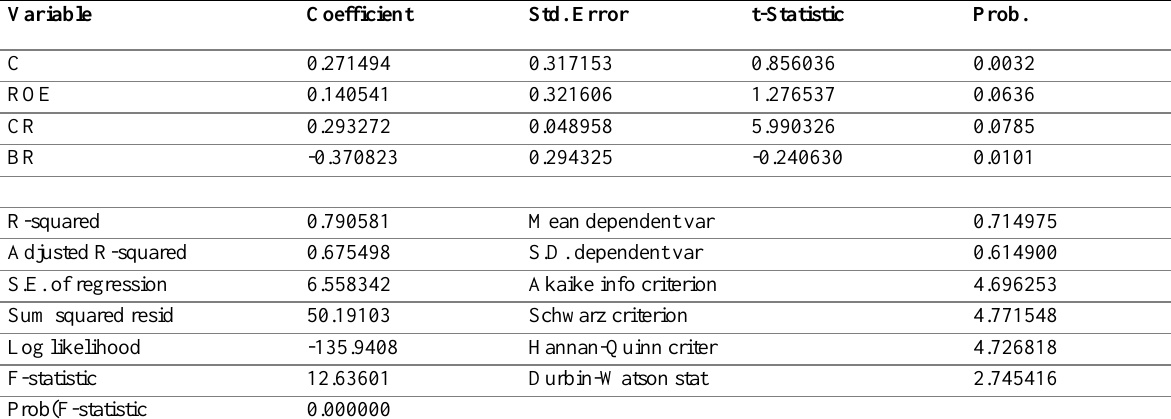
Table 2: Regression Results of Model